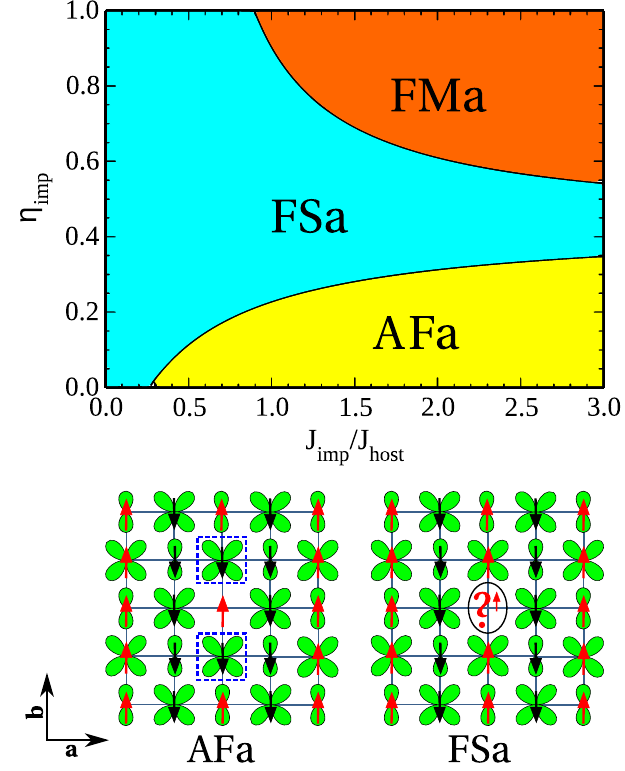
FIG. 6. Top: Phase diagram of the 3 d impurity in the ð a; b Þ plane with the C -AF or G -AO order in the 4 d host for the impurity doped at the sublattice with an a -orbital doublon. Different colors refer to local spin order around the impurity (AF and FM), while FS indicates the intermediate regime of frustrated impurity spin. Bottom: Schematic view of spin-orbital patterns for the ground-state configurations shown in the top panel. The 3 d atom is at the central site; the dotted frame highlights the 4 d sites where the impurity induces a a spin reversal. In the FS a phase, the question mark stands for the frustrated impurity spin within the classical approach, but frustration is released by the quantum fluctuations of the NN c orbitals in the a direction, resulting in small AF couplings along the a axis, and spins obey the C -AF order (small arrow). The labels FM a and AF a refer to the local spin order around the 3 d impurity site with respect to the host — these states differ by spin inversion at the 3 d atom site.